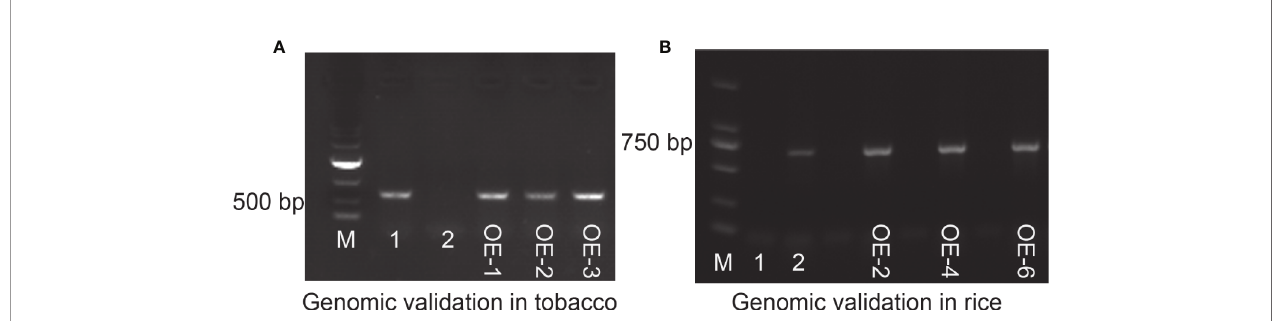
FIGURE 1 | Electrophoretic results to con fi rm the presence of the ZmMYB59 gene in T 2 generation transgenic tobacco and rice in genomic level. (A) T 2 generation transgenic tobacco. M: DL10000 DNA Marker, 1: positive control, 2: negative control, OE1~OE3: ZmMYB59 transgenic tobacco lines. (B) T 2 generation transgenic rice. M: DL2000 DNA Marker, 1: negative control, 2: positive control, OE2~OE6: ZmMYB59 transgenic rice lines. Seedlings of 14 day-old were used for DNA extraction.